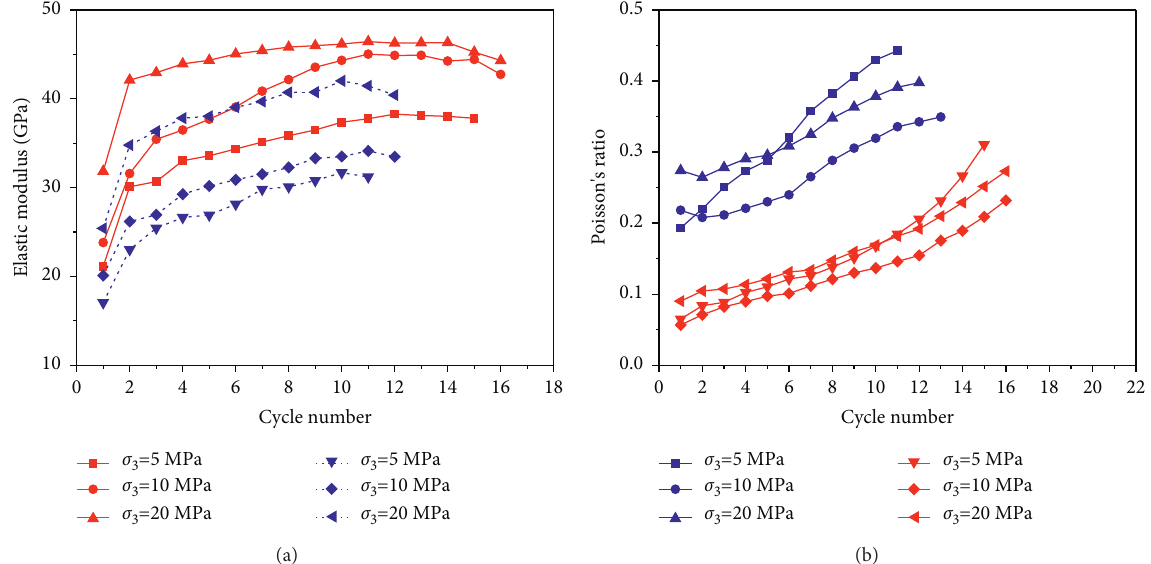
Figure 5: Elastic modulus and Poisson’s ratio (blue denotes saturated phyllite and red denotes dry phyllite; σ (a) elastic modulus and (b) Poisson’s ratio.